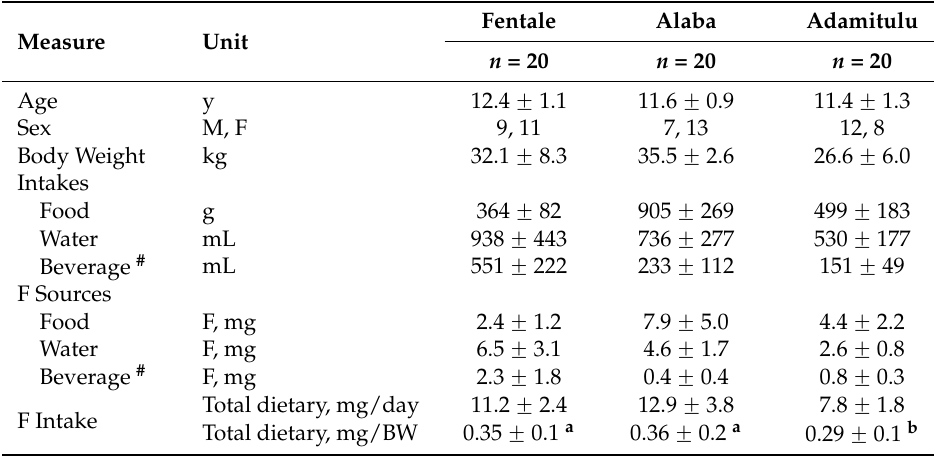
Table 1. Characteristics of subjects, dietary intakes of fluoride, and derivation of total dietary fluoride (F) intake (mean ˘ SD) by